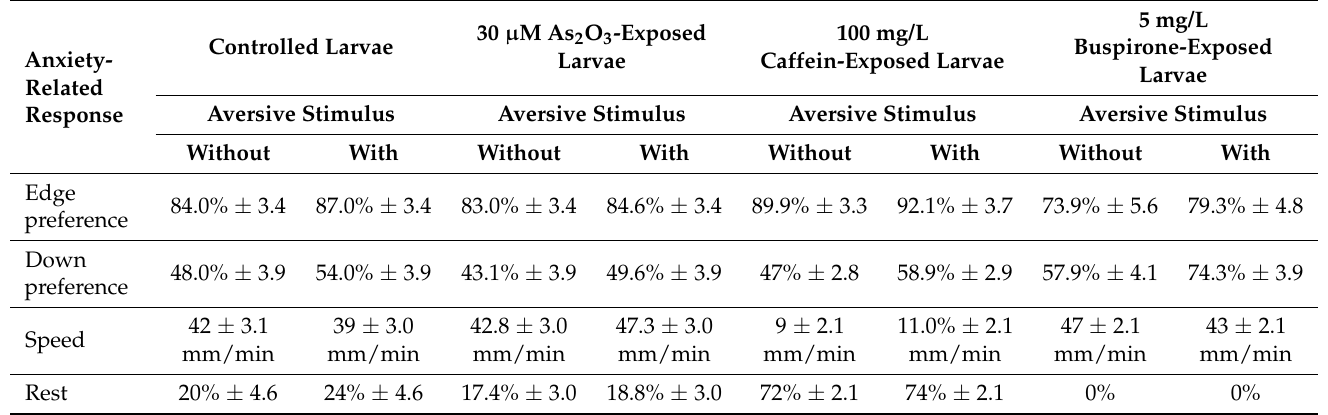
Table 1. Changes in anxiety-related responses in As 2 O 3 -, caffeine-, or buspirone-exposed